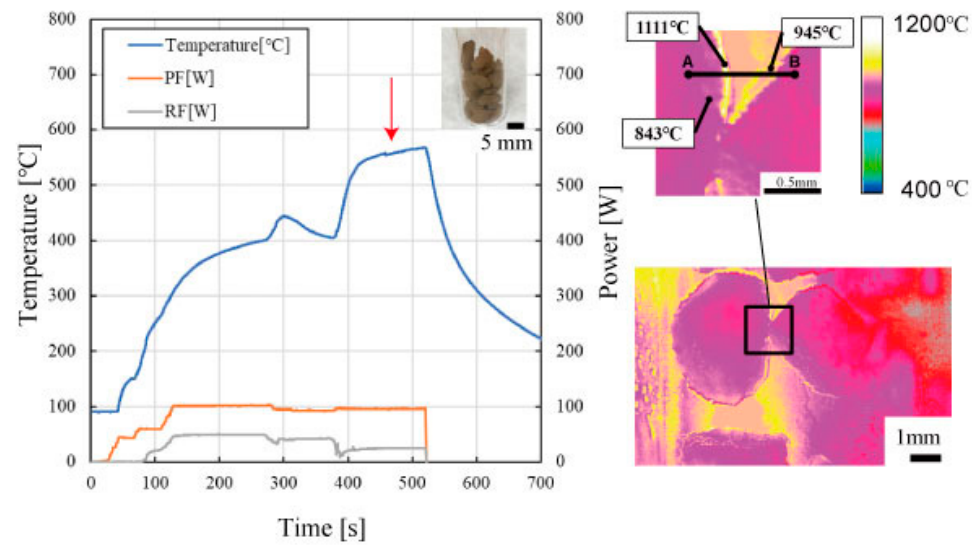
Figure 6. Time vs. temperature plots of Al 4 SiC 4 particles (2 mm) during microwave electric field heating at 200 W and two-dimensional two-colour thermometer measurement results.